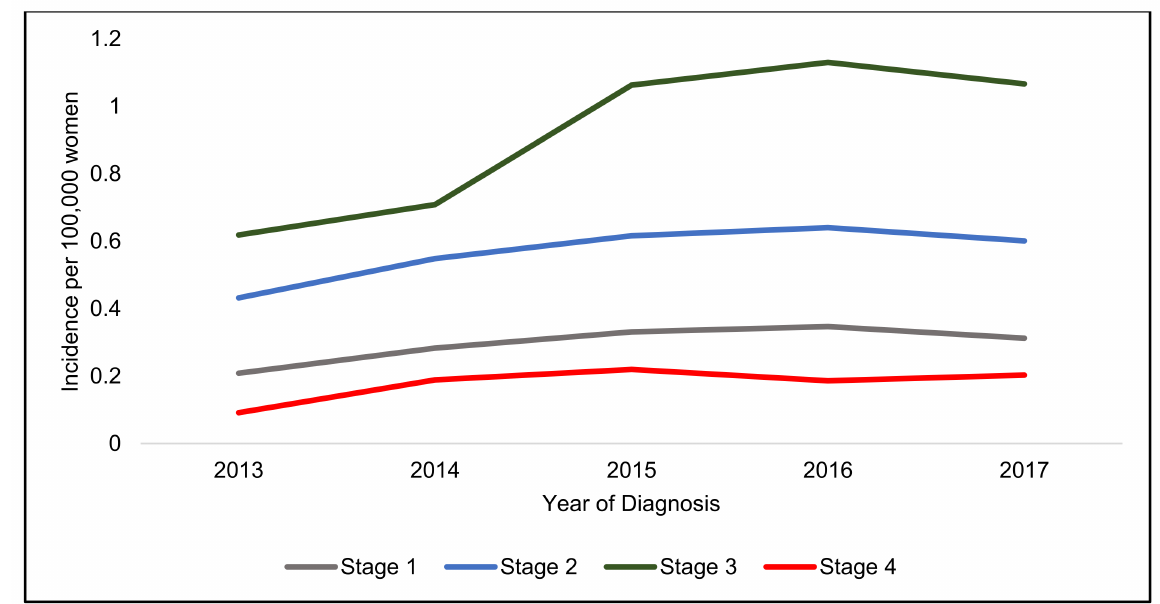
Figure 3. Incidence per 100,000 women in England from 2013–2017 stratified by stage.